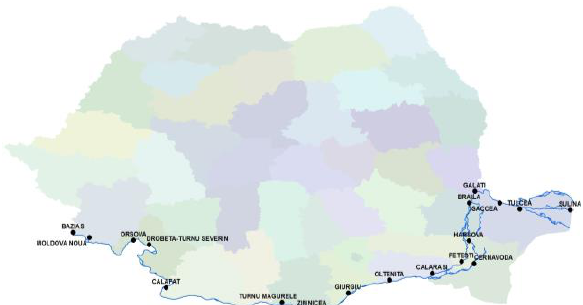
Figure 2. Danube River in